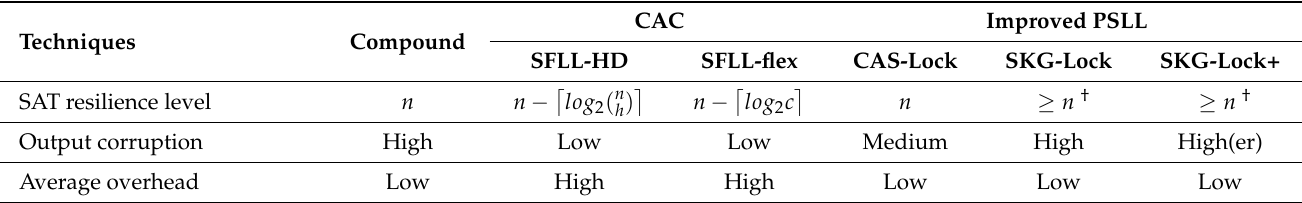
Table 5. Comparison of SKG-Lock+ with related